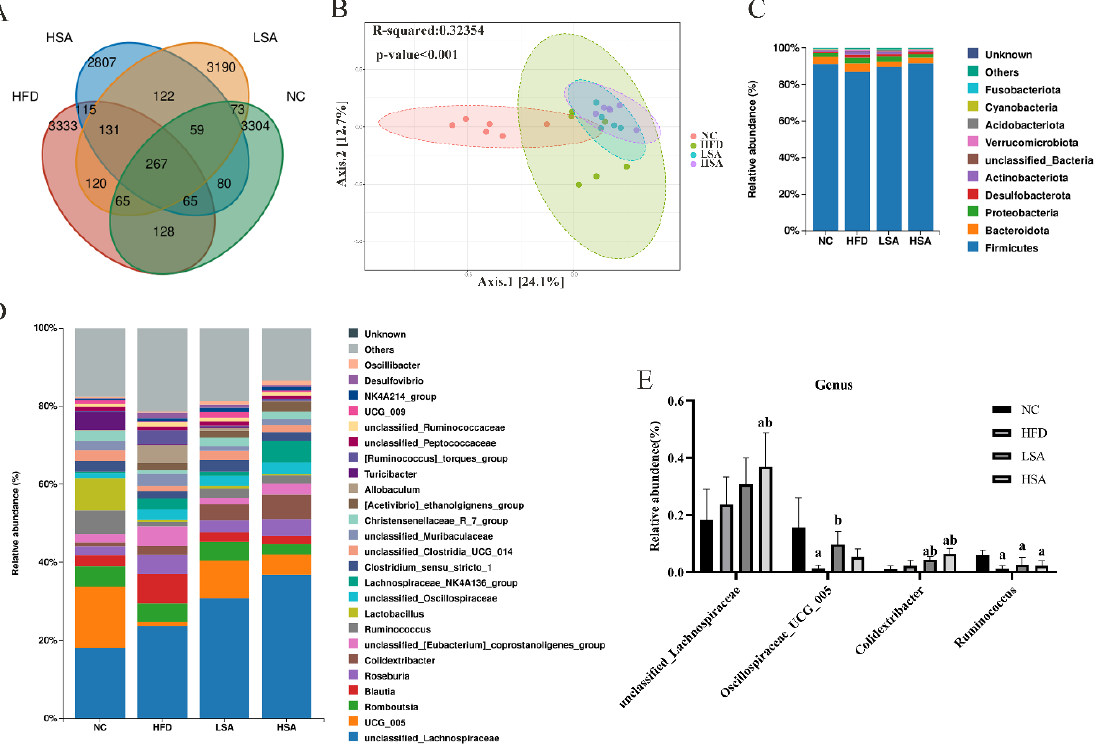
Figure 4. SA supplementation altered overall gut microbial structure. ( A ) Venn diagram, the num- bers indicated sequencing reads; ( B ) principal coordinates analysis; ( C ) the microbial distributions at the phylum level; ( D ) the microbial distributions at the genus level; ( E − G ) relative abundance of bacteria at the genus level. n = 5 − 6 each group. a p < 0.05, compared to the NC group; b p < 0.05, compared to the HFD group; c p < 0.05, compared to the LSA group. 3.5. SA Supplementation Affected the Gut Microbiota-Derived Metabolites Gut microbiota metabolites (SCFAs and LPS) were determined, and the experimental data are represented in Figure 5. The serum levels of LPS in the HFD group were higher than those in the NC group ( p < 0.05). The increased serum LPS in the HFD group was